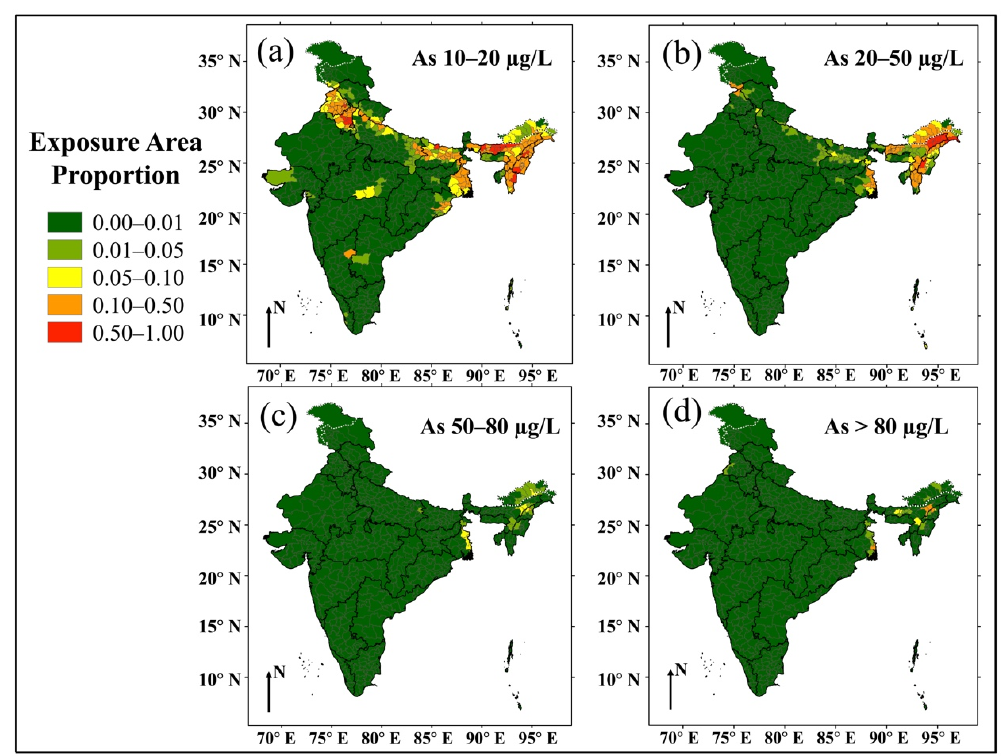
Figure 3. District-wise distribution of modelled percentage of district areas with groundwater arsenic in the concentration ranges of ( a ) 10 to 20 μg/L, ( b ) 20 to 50 μg/L, ( c ) 50 to 80 μg/L, and ( d ) >80 μg/L.